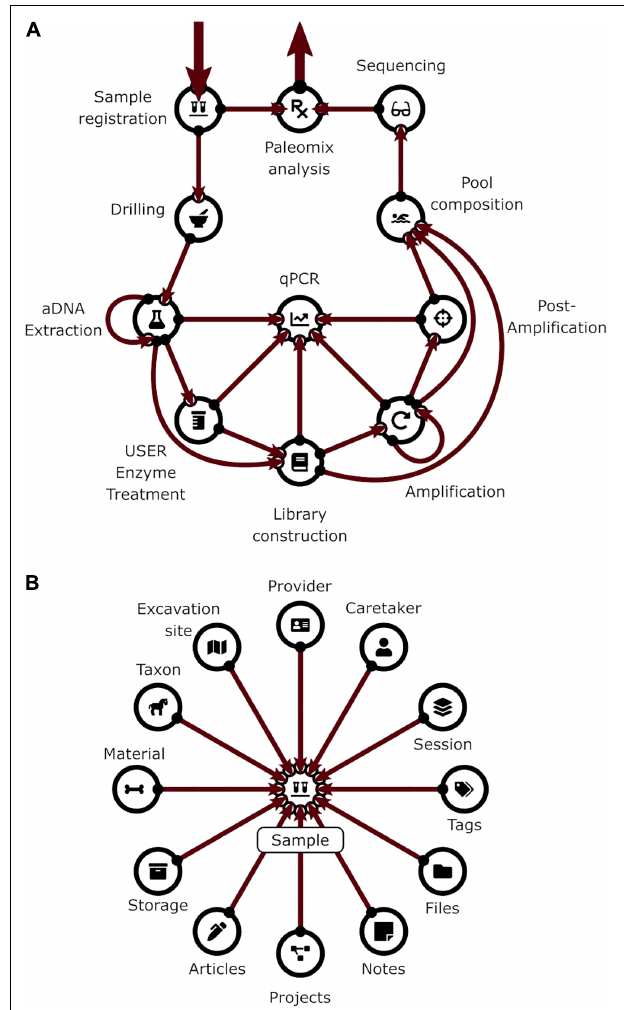
FIGURE 1 | (A) Pipeline backbone graph showing the flow of experimental data through CASCADE. Samples and their related data are registered first. Subsequently, they proceed through the pulverization or “ Drilling ” stage to the extraction step. Once extracted, they continue to library generation, either directly or after undergoing USER treatment. Should analyses reveal that the initial extraction round did not succeed in releasing satisfactory endogenous material, new extractions can also be generated from the remaining extraction pellets (loop from and to extraction) before being further processed. Generated libraries can be pooled immediately or after additional amplification. Again, should initial amplification prove not to be sufficient, re-amplification (loop from and to amplification), target enrichment, or other post-amplification protocols can be executed prior to pooling. All intermediates from extraction to post-amplification can be included in analyses via the feature “ qPCR .” Paths to the sequencing data generated for several samples of the same specimen (a “ Sample group ”) are combined and fed in the Paleomix computational pipeline (Schubert et al., 2014) for retrieving basic estimates, including endogenous content. The results obtained represent the final pipeline output. (B) Display of the most important non-experimental data types related to sample data. Samples have the largest number of relations to non-experimental data. Some of these are shared